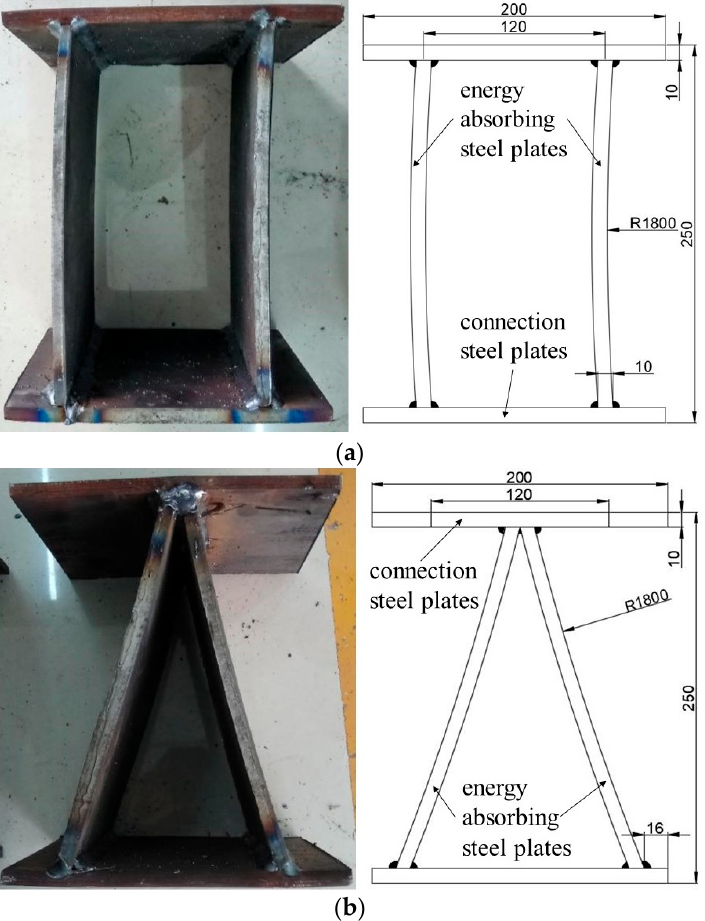
Figure 4. Two kinds of arc energy-absorbing dampers: ( a ) arc energy-absorbing damper I (AED-I); ( b ) arc energy-absorbing damper II (AED-II).